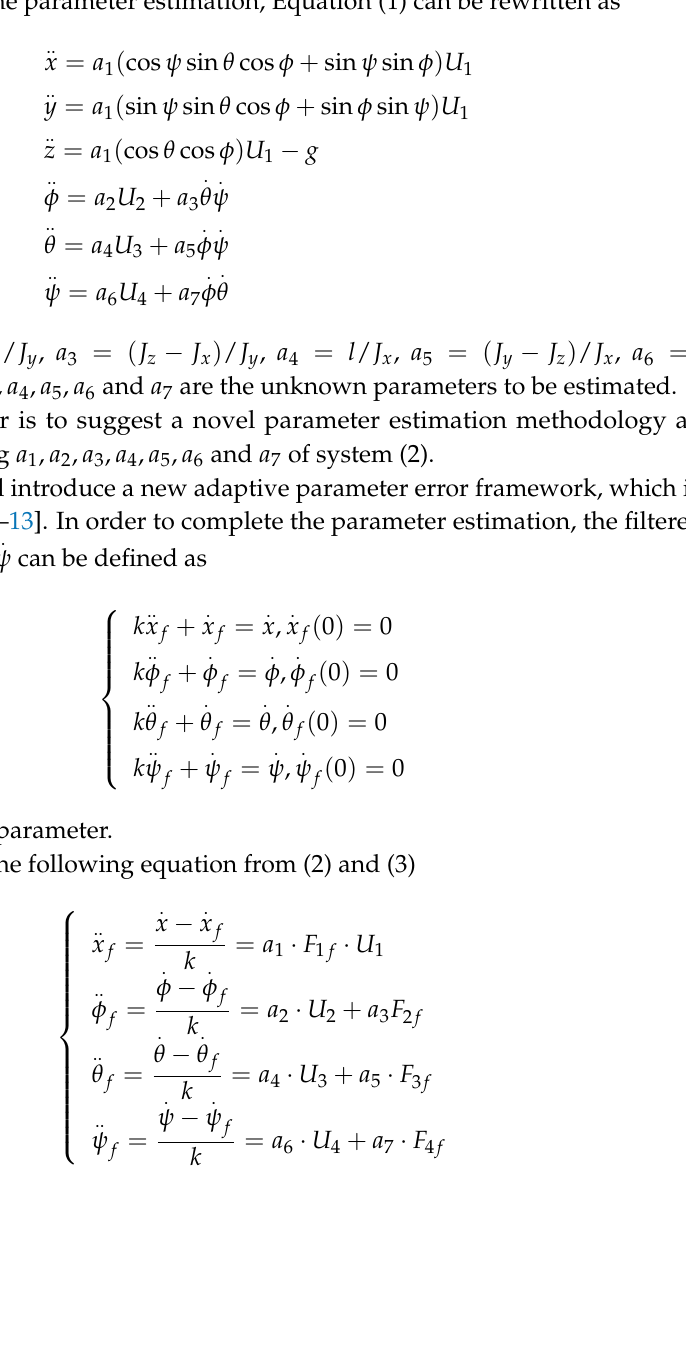
Figure 1. The schematic diagram of the ground coordinate system and the body axes coordinate system.